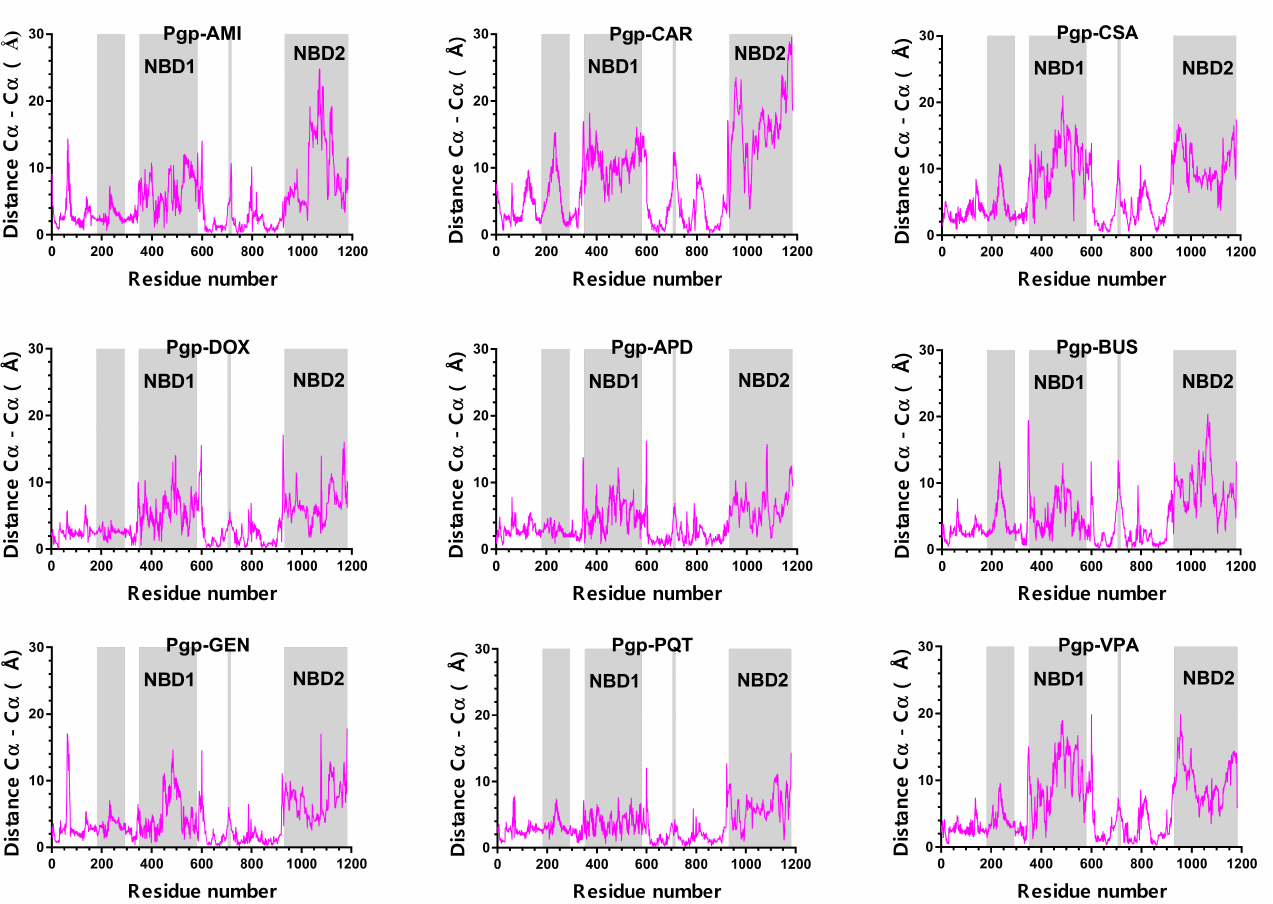
Figure 9. C α distance between the centroids of the most-populated cluster in each system and the cryoEM structure of the h P-gp (PDB ID: 6QEX). The residue numbers do not correspond to the numbers in the PDB file of the cryo-EM structure, but are consecutive, as required by the simulation